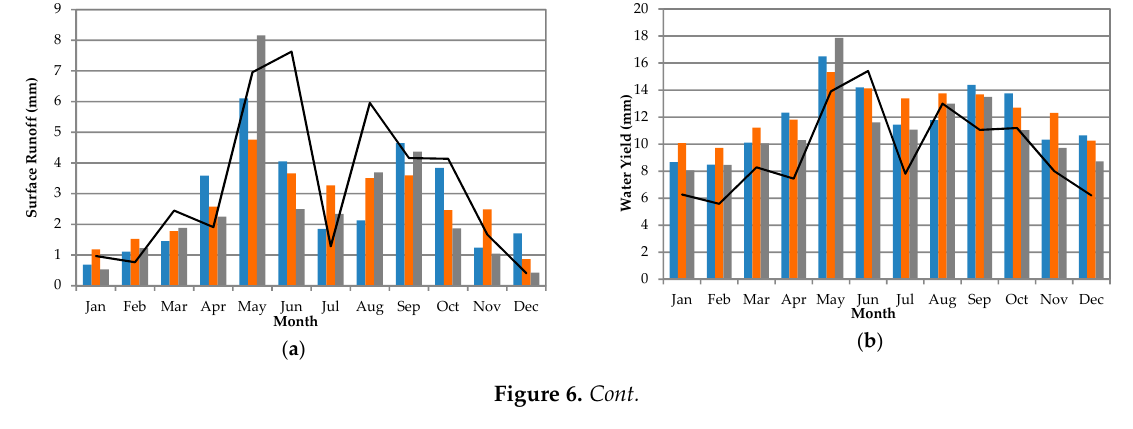
( d ) Figure 6. Model simulated ( a ) total monthly surface runoff, ( b ) total monthly water yield, ( c ) total monthly evapotranspiration, and ( d ) seasonal total water yield under historical (1986–2010) and future (2016–2040) climate. The values are presented as an average of all three Global Climate Models (GCMs) for each representative concentration pathways (RCP). 3.3. Crop Yield The overall mean of climate scenarios indicated decreased yields for winter wheat ( − 225.07 kg/ha, − 5.2%) and sorghum ( − 433.24 kg/ha, − 9.9%), and increased yields for cotton (328.67 kg/ha, +54.2%) for the period 2016–2040 relative to the historical mean annual yields (Table 6). The modeled future winter wheat yield varied between − 23.0% and +5.8%, with the greatest decline in MPI-ESM- LR/RCP 8.5 and the greatest increase in CCSM4/RCP 2.6 (Table 6). Of the nine future climate scenarios modeled, the winter wheat yield decreased in five. It was found that sorghum yields were consistently lower ( − 16.5% to − 1.9%) and cotton yields higher (18.2% to 105.9%), compared to the historical yield in all nine climate scenarios.